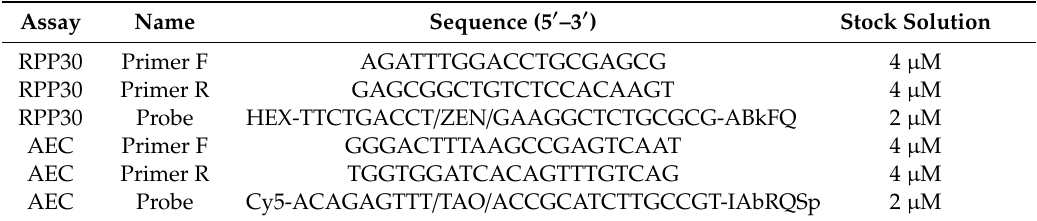
Table 3. RT-PCR primer and hydrolysis probe sequences for the sample collection control (RPP30) [6] and for the artificial external RNA control (AEC) (This